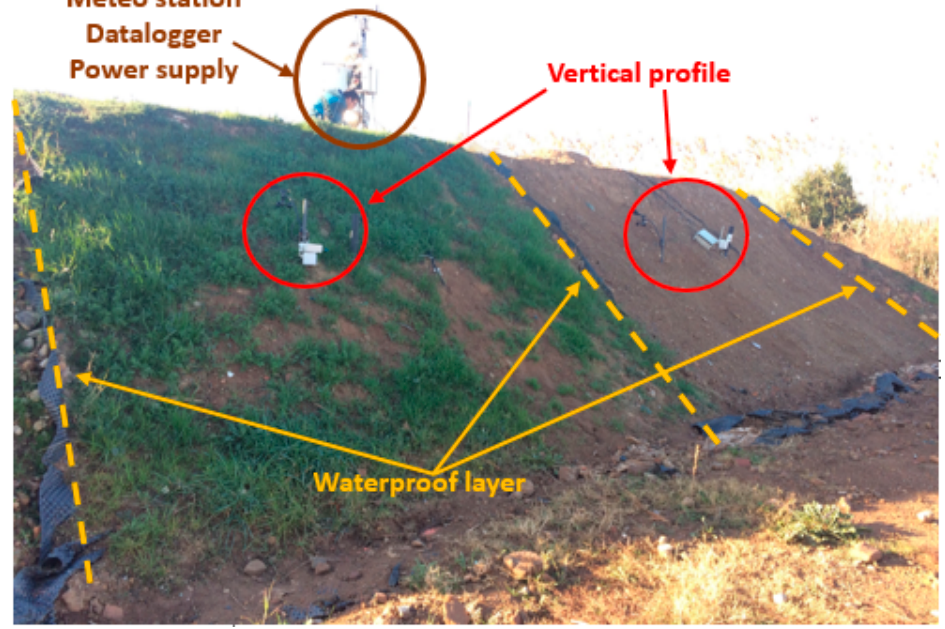
Figure 3. Photograph of the embankment after installation of the sensors looking towards the North slope.